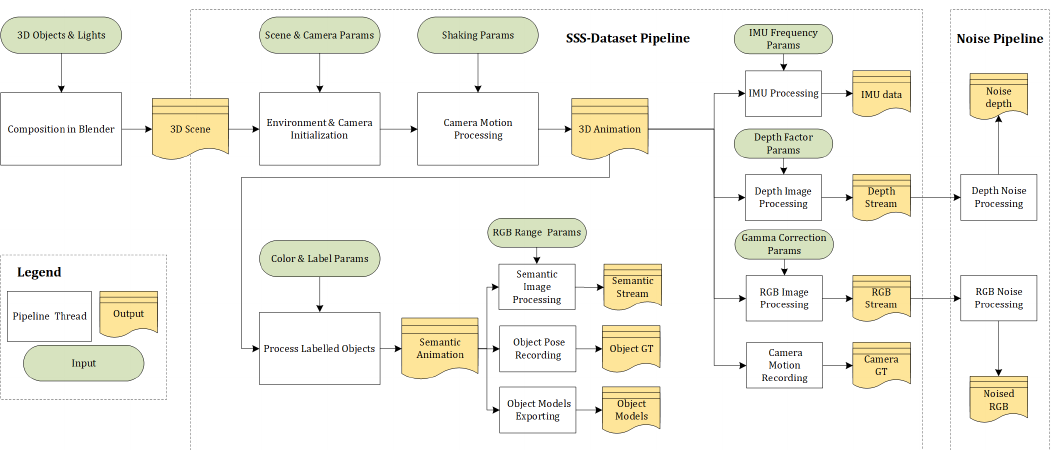
Figure 12. Pipeline for generating datasets. The green boxes represent parameters that can be tuned for customised dataset generation, the white boxes are core codes to generate results in yellow boxes, including RGB, depth and semantic maps, camera poses, object poses, object 3D models, IMU data, and depth and RGB noise.